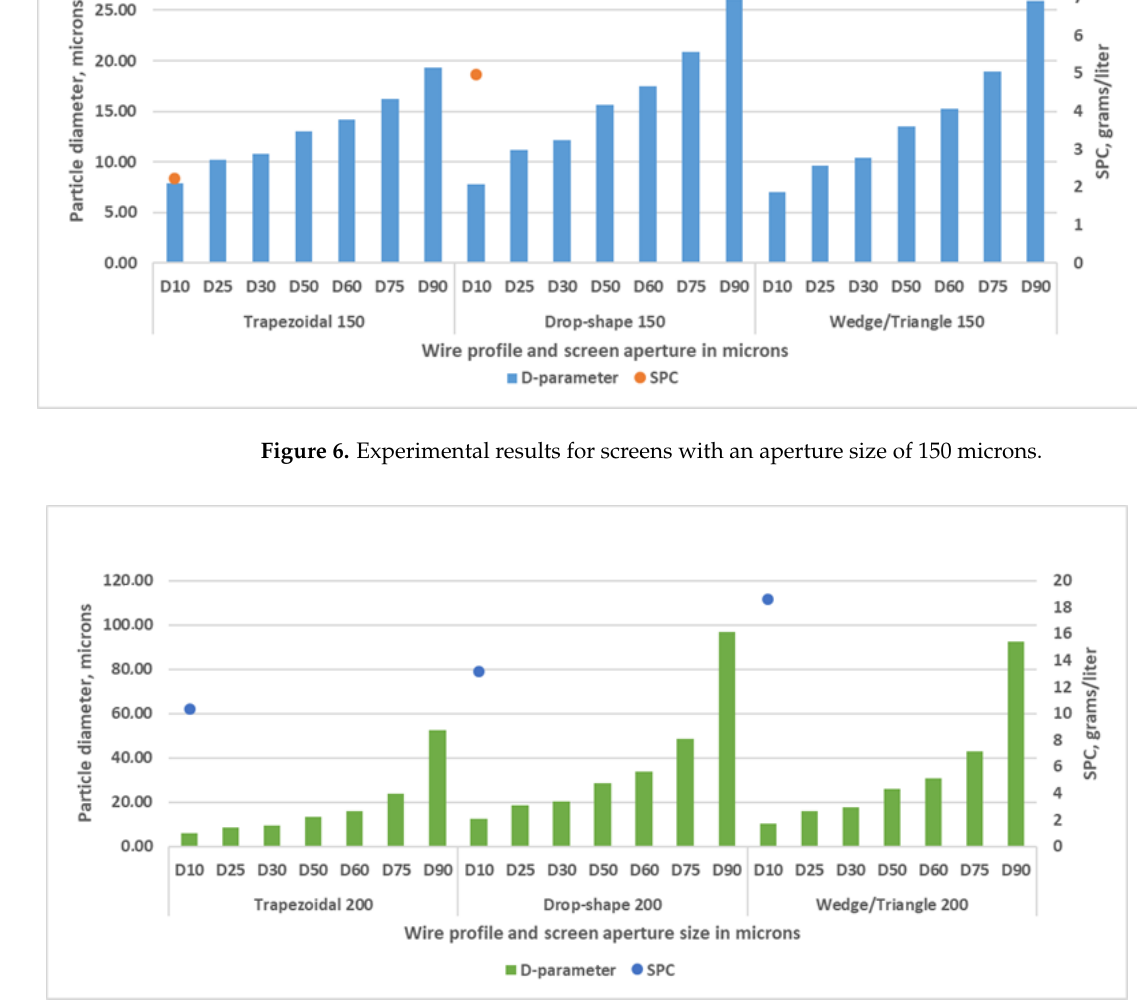
Figure 7. Experimental results for screens with an aperture size of 200 microns.